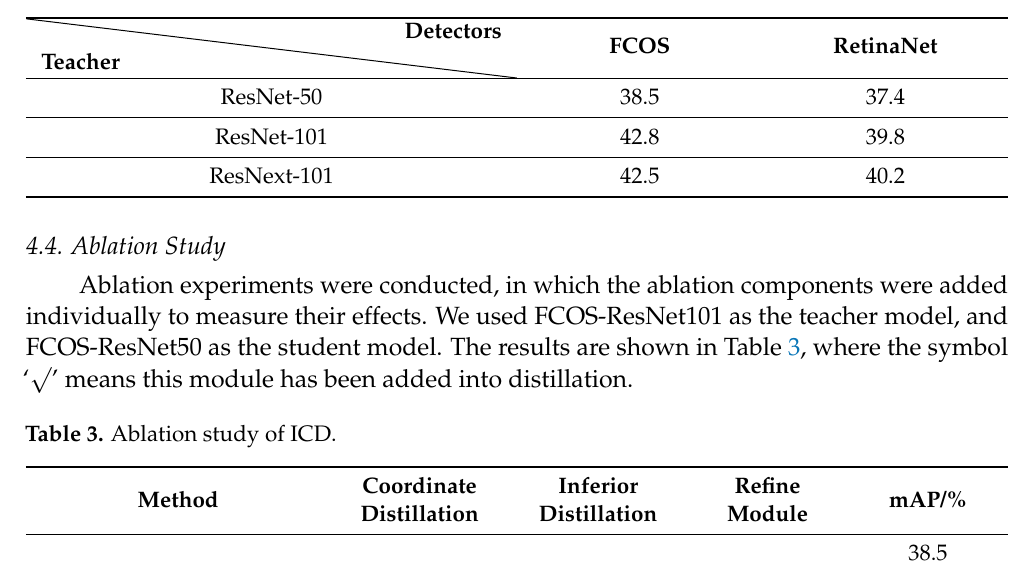
Table 2. Effects of different teacher models on distillation.